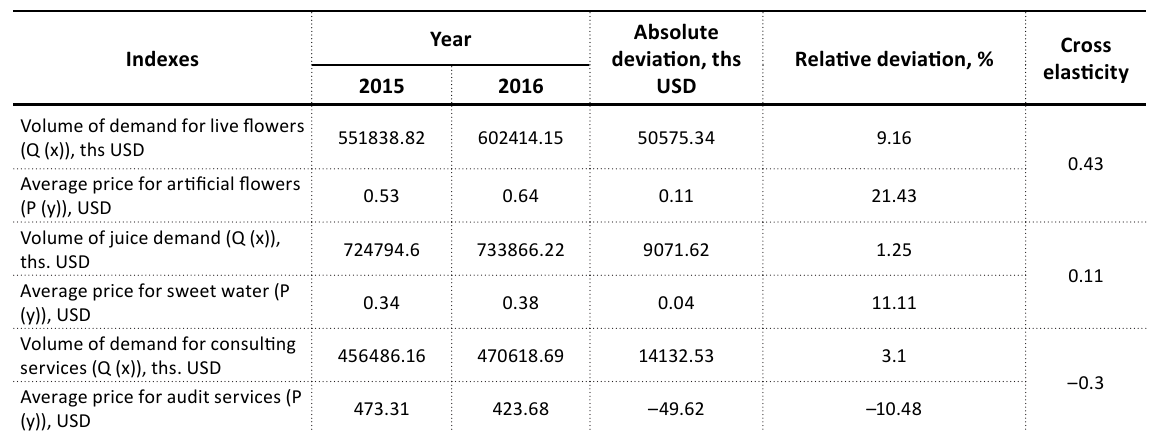
Table 2. Cross-elasticity